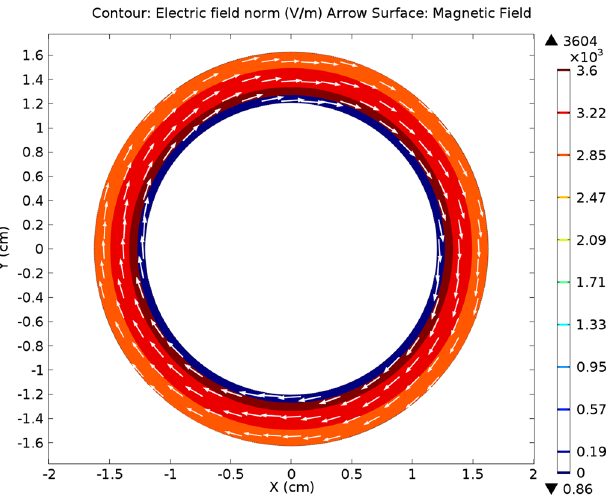
FIG. 13. Current and magnetic pressure for 96-brick